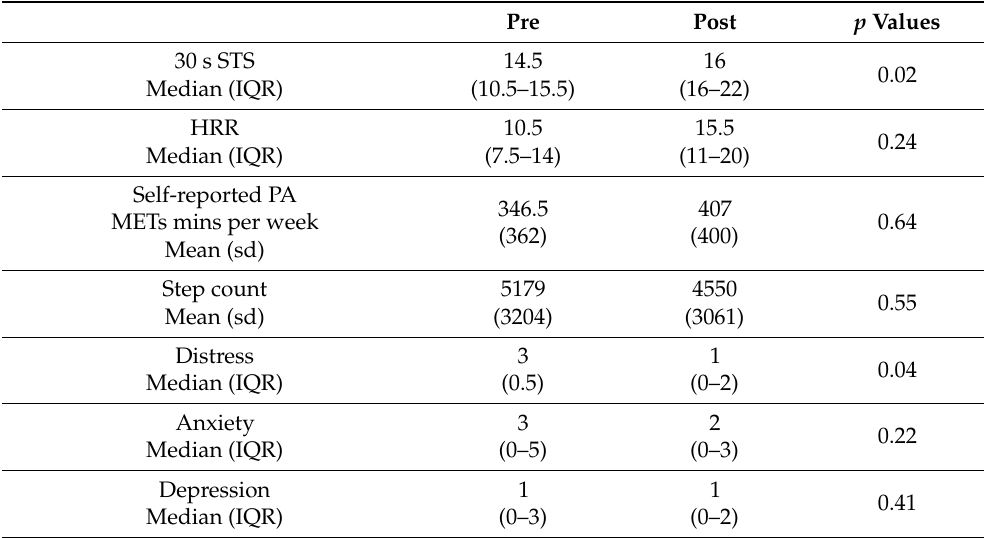
Table 1. Changes in physical and psychological health